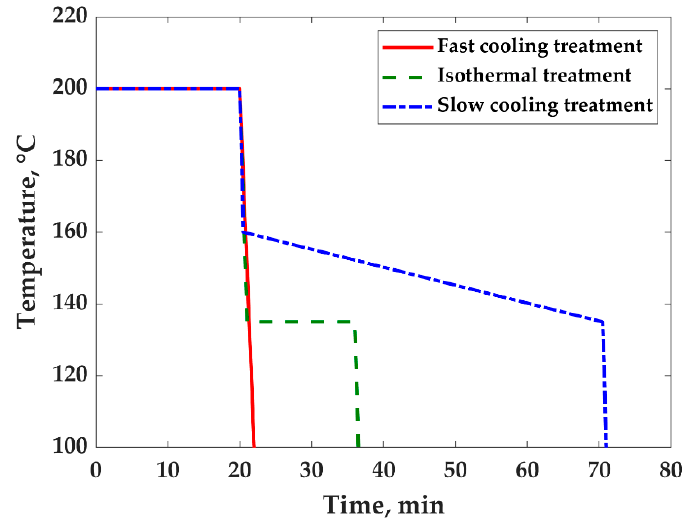
Figure 1. Temperature vs. time for fast-cooling treatment, isothermal treatment, and slow-cooling treatment.